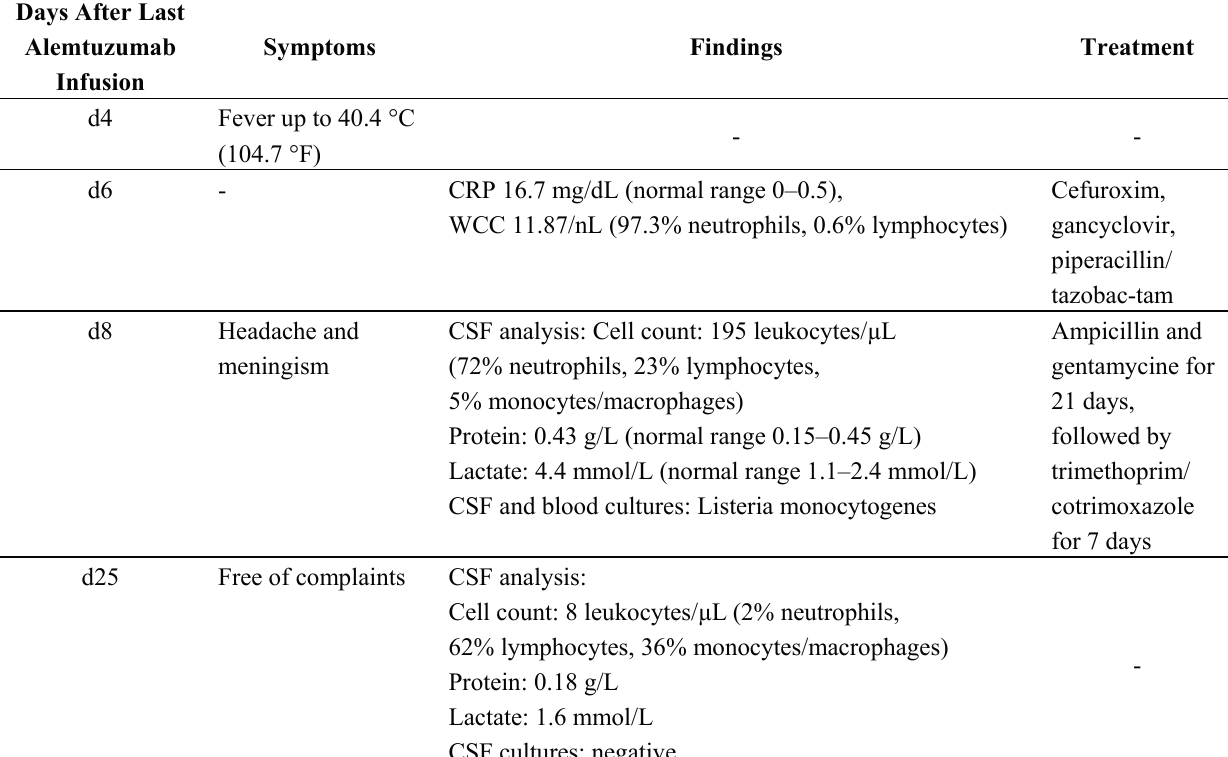
Table 3. Clinical symptoms and CSF findings in case